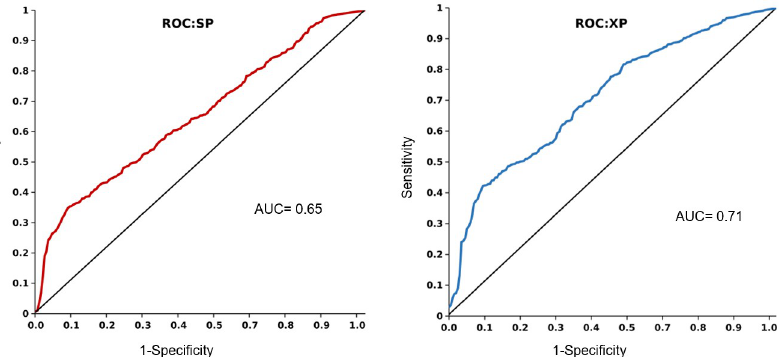
Fig 5. Docking enrichment in GLIDE SP and XP mode against HDAC2. The AUC value describes the ability to discriminate the number of screened actives out of the pool of random decoys and actives. (AUC value � 0.68 ! Fair).